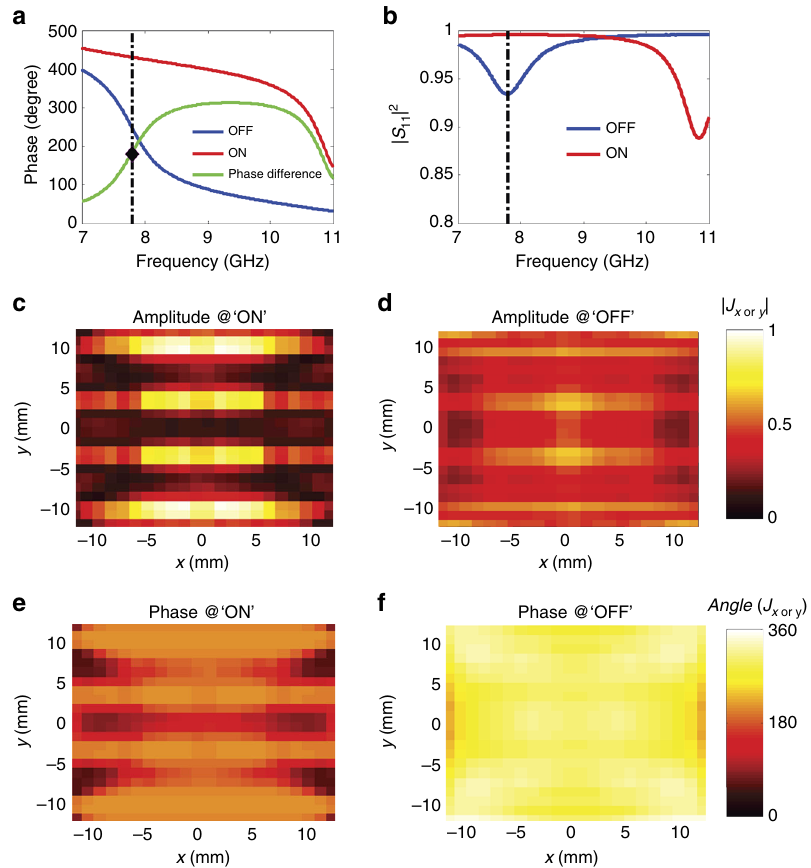
Fig. 2 Phase and amplitude of the metasurface supercell. a The phase responses of the metamaterial supercell as the biased diode is ‘ OFF ’ and ‘ ON ’ over a range of frequencies. b The re fl ection ef fi ciency of the metaatom when the biased diode is at the state of ‘ OFF ’ and ‘ ON ’ . c – f The distributions of normalized amplitudes and phases of the equivalent currents on the half-wavelength supercell as the biased diode is at ‘ OFF ’ and ‘ ON ’ states. The equivalent current is retrieved at the frequency of 7.8 GHz by performing the source inversion